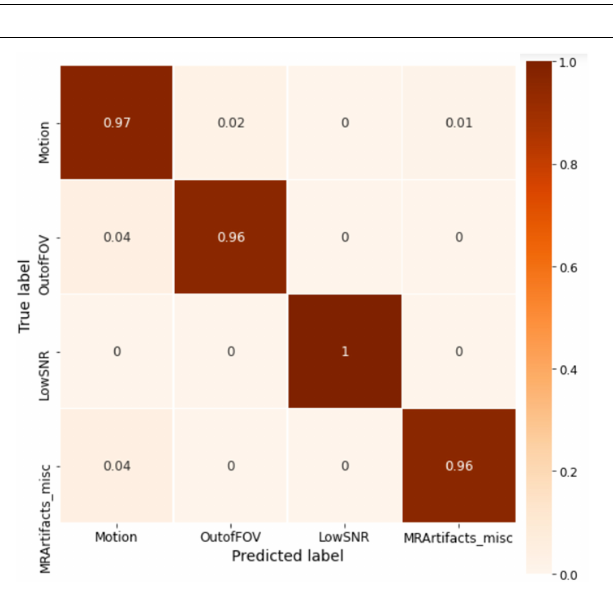
FIGURE 7 | The slab-level confusion matrix for the ABCD test set. The matrix shows roughly a diagonal behavior with minor misclassifications between motion and out of FOV classes.